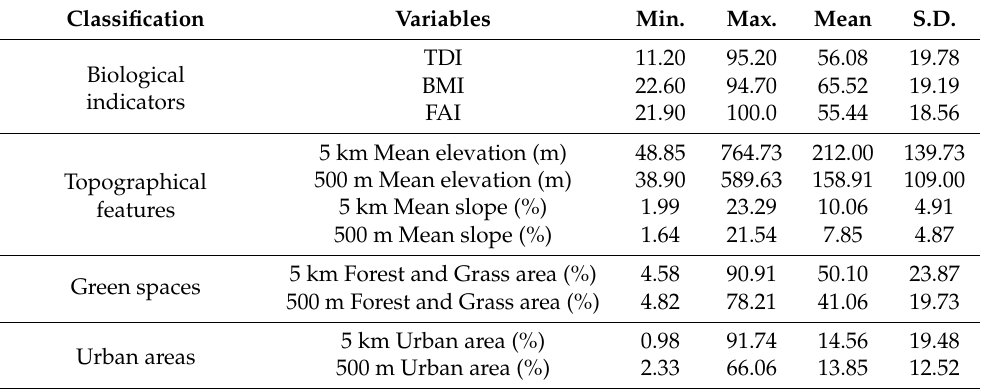
Table 2. Descriptive statistics of biological indicators, topographical features, and green/urban areas in the Nam-Han River Basin.